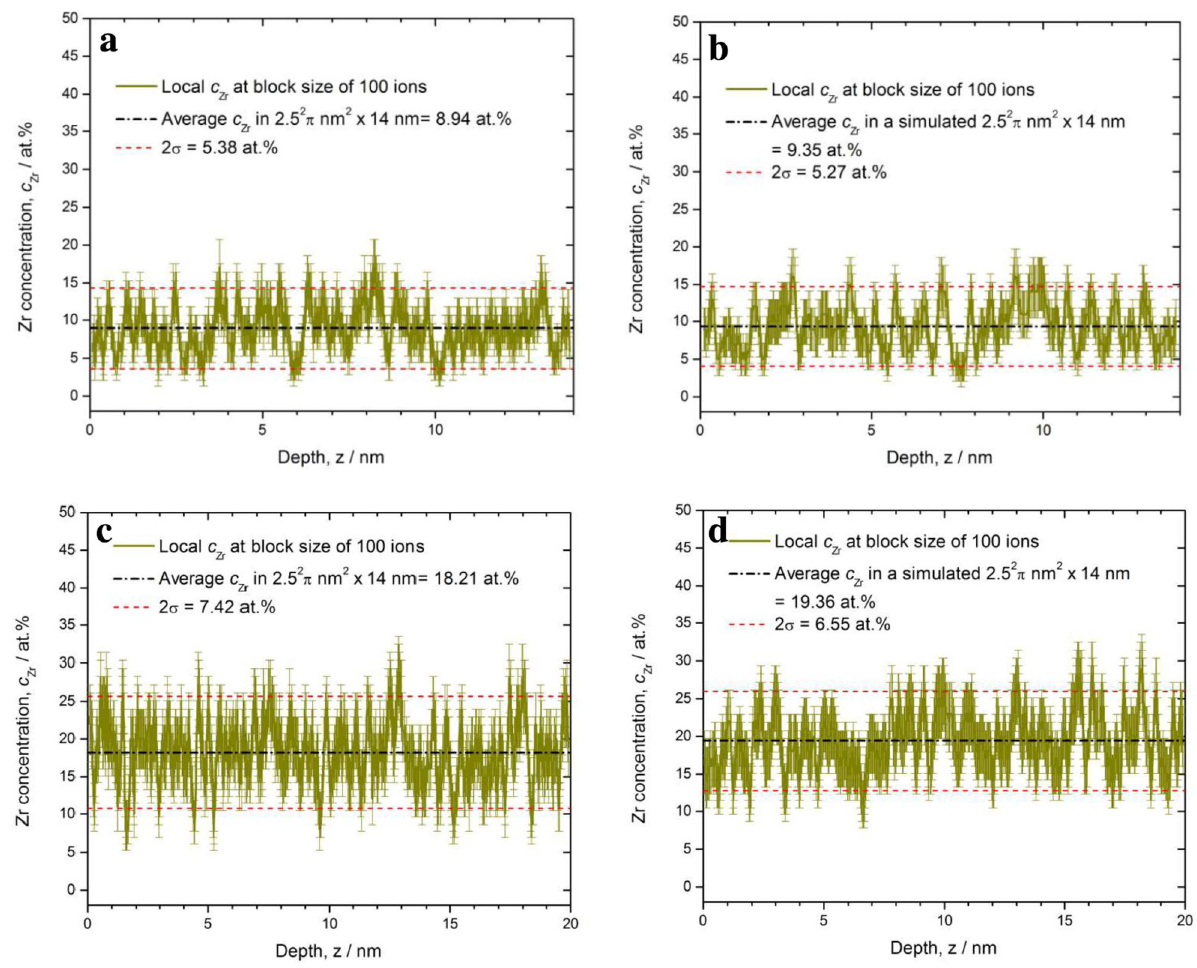
Fig. 6. ( a ) Measured concentration depth profile of Fe 0.91 Zr 0.09 alloy. ( b ) Simulated depth profile from a simulated volume of Fe 0.91 Zr 0.09 . ( c ) Measured concentration depth profile of the Fe 0.81 Zr 0.19 alloy ( d ) Simulated depth profile of the Fe 0.81 Zr 0.19 alloy. The concentration was obtained by averaging over 100 atoms. No differences are observed between the measured and the simulated alloy in a concentration depth profile of this length